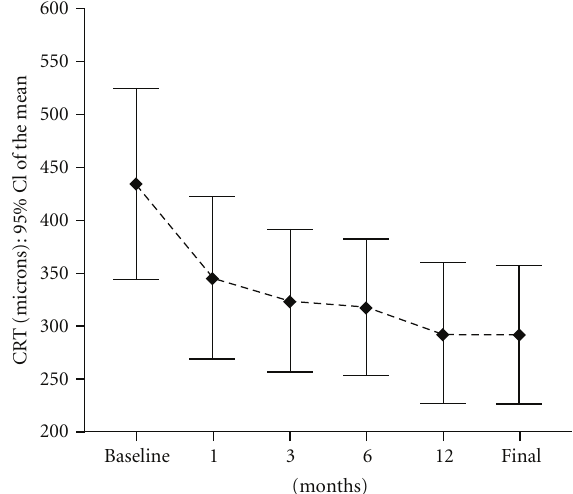
Figure 2: Evolution of change in retinal thickness over 14 months after intravitreal injection of bevacizumab showing statistically significant